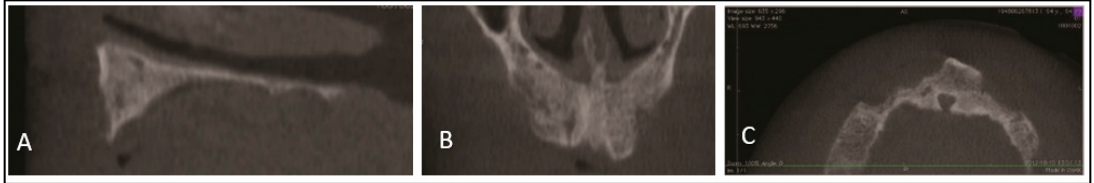
Figure 2. Cone beam computed tomography (CBCT) analysis before surgical treatment showed severe bone atrophy in the pre-maxilla area: ( A ) sagittal view, ( B ) coronal view and ( C ) axial view.